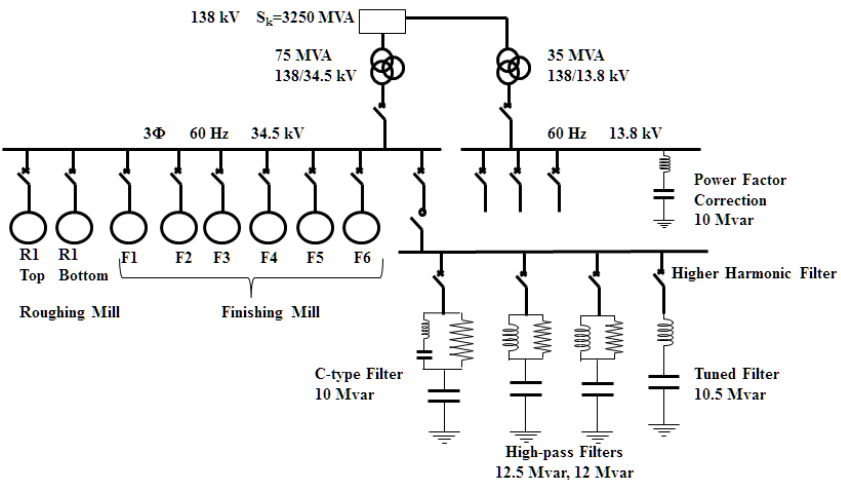
Figure 2. Diagram of the distribution network and filtering system.